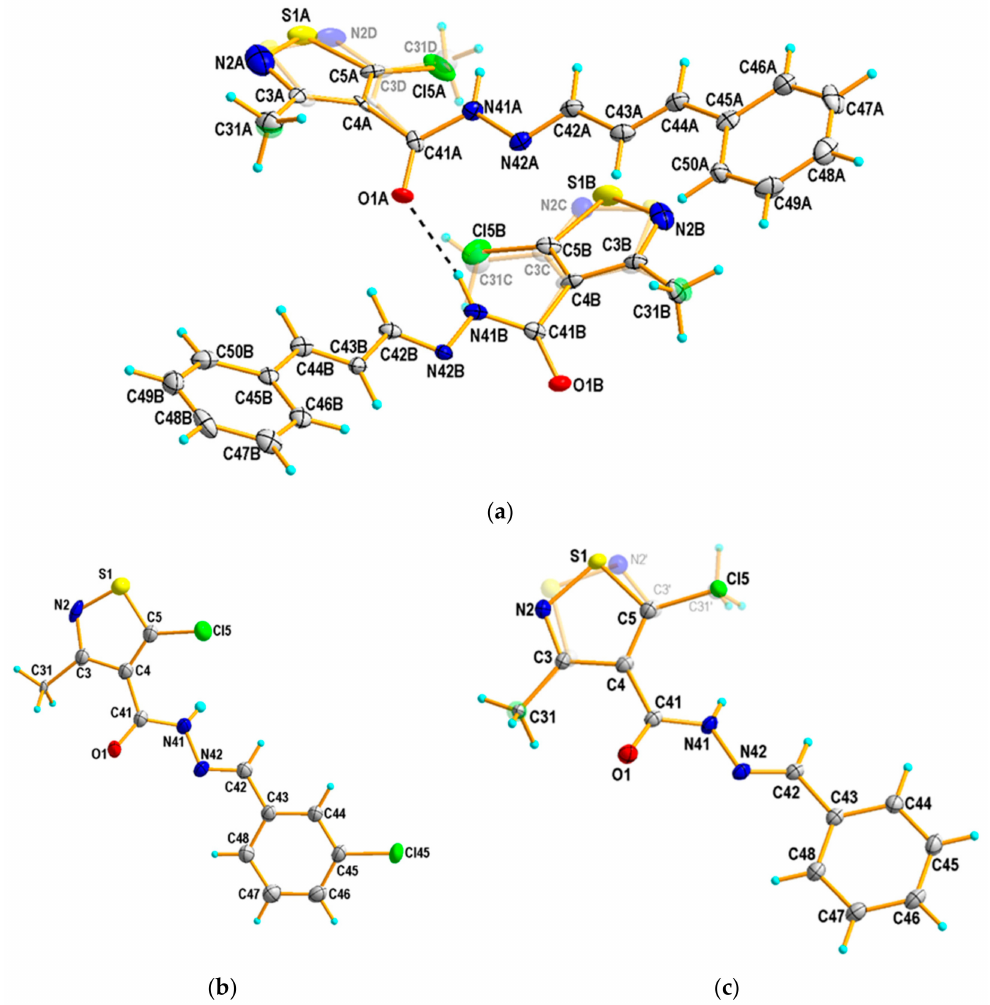
Figure 2. X-ray structures of 3 ( a ) (the dotted line indicates N-H ... O hydrogen bond which linking together both independent molecules—denoted as A and B), 4 ( b ) and 8 ( c ), with atom-numbering scheme. Displacement ellipsoids are drawn at the 50% probability level. H atoms are shown as small spheres of arbitrary radii. For compounds 2 and 3 , atoms and bonds from a disordered isothiazole ring with a lower occupancy factor were marked with a transparency of